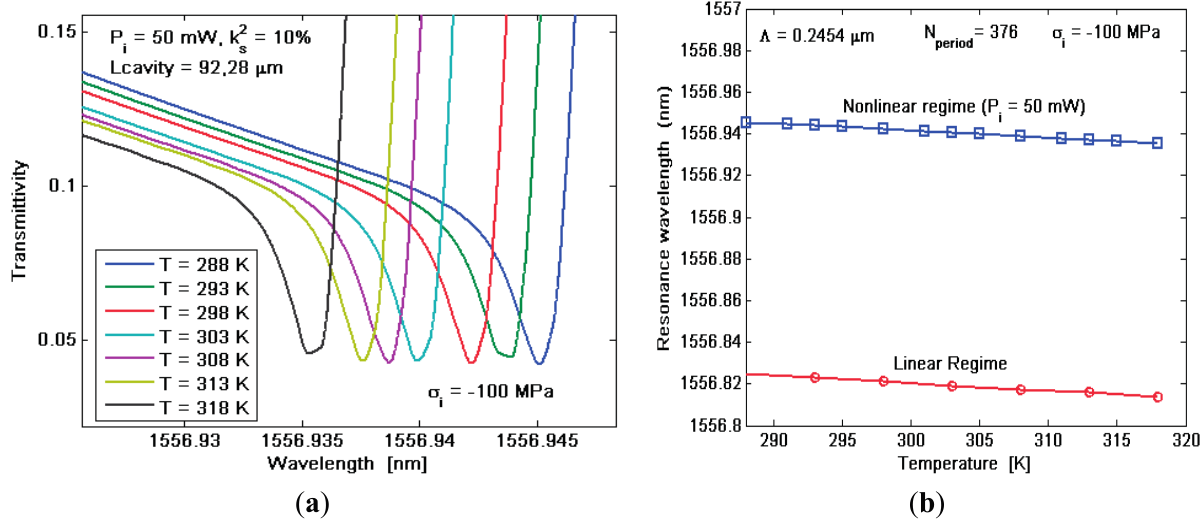
Figure 8. ( a ) Transmittivity versus wavelength for different temperatures; ( b ) Resonance wavelength versus